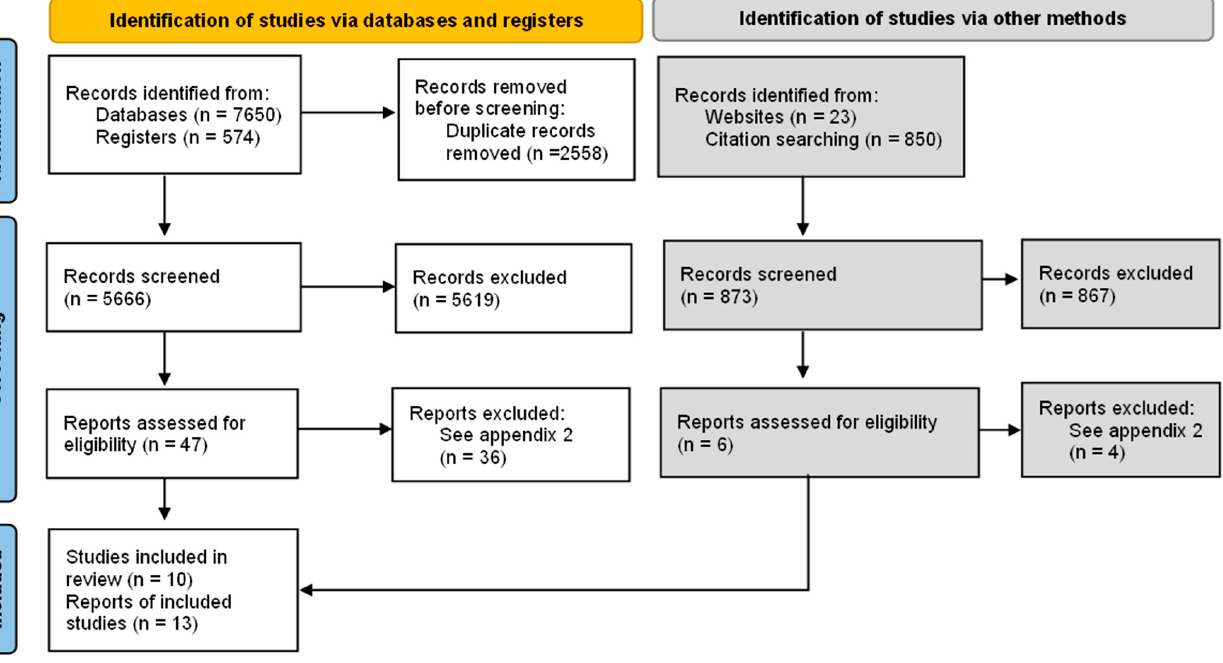
Figure 1. Flowchart of studies selection. Source: The PRISMA 2020 statement: an updated guideline for reporting systematic reviews [30].